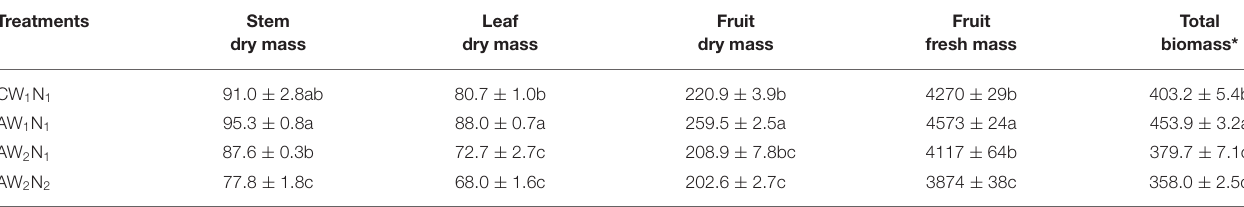
TABLE 1 | Effects of irrigation and nitrogen (N) supply on tomato biomass (g plant − 1 ) and yield (g plant − 1 ) under alternate partial root-zone drip N fertigation. Treatments Stem